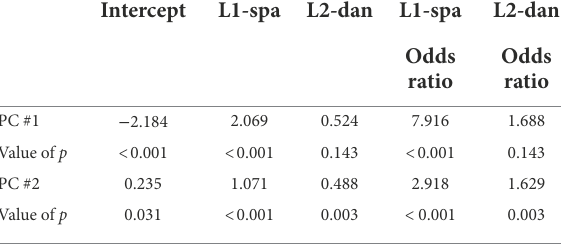
TABLE 6a Multinomial logistic regressions with PC #3 as baseline (L1-Danish baseline).